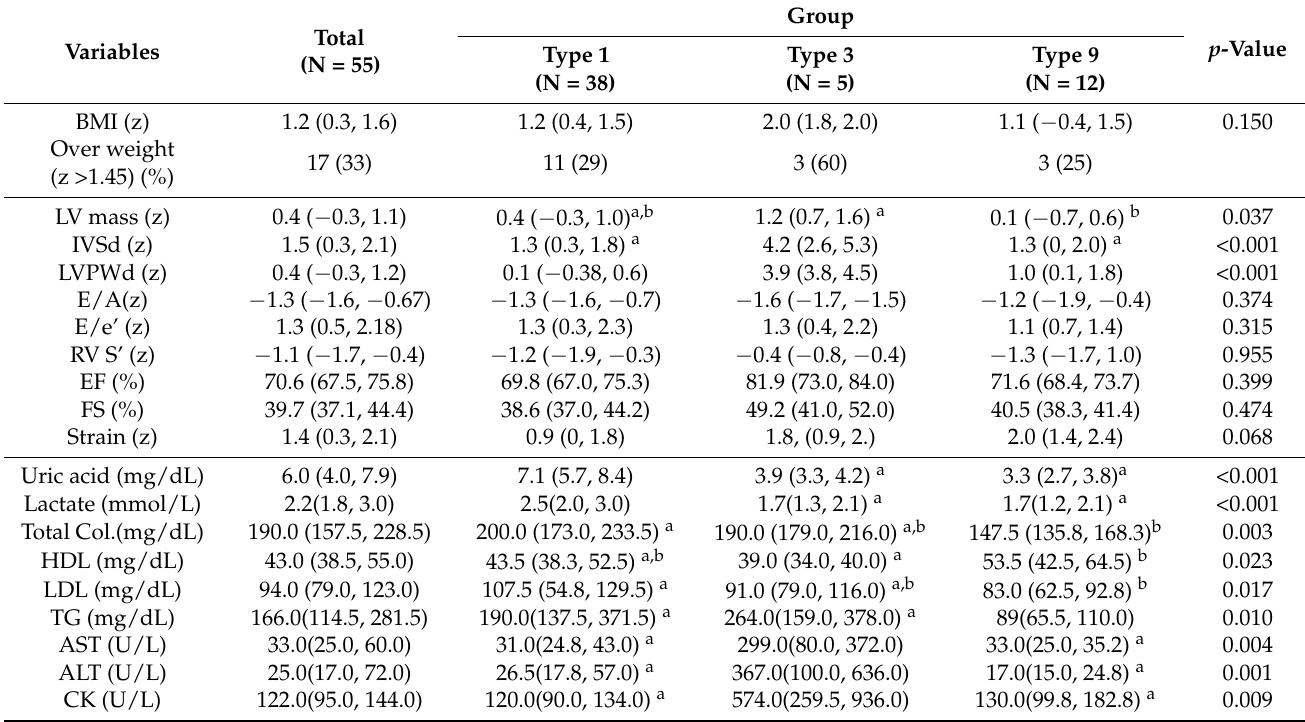
Table 2. BMI z scores and echocardiography results of children aged < 18 years.